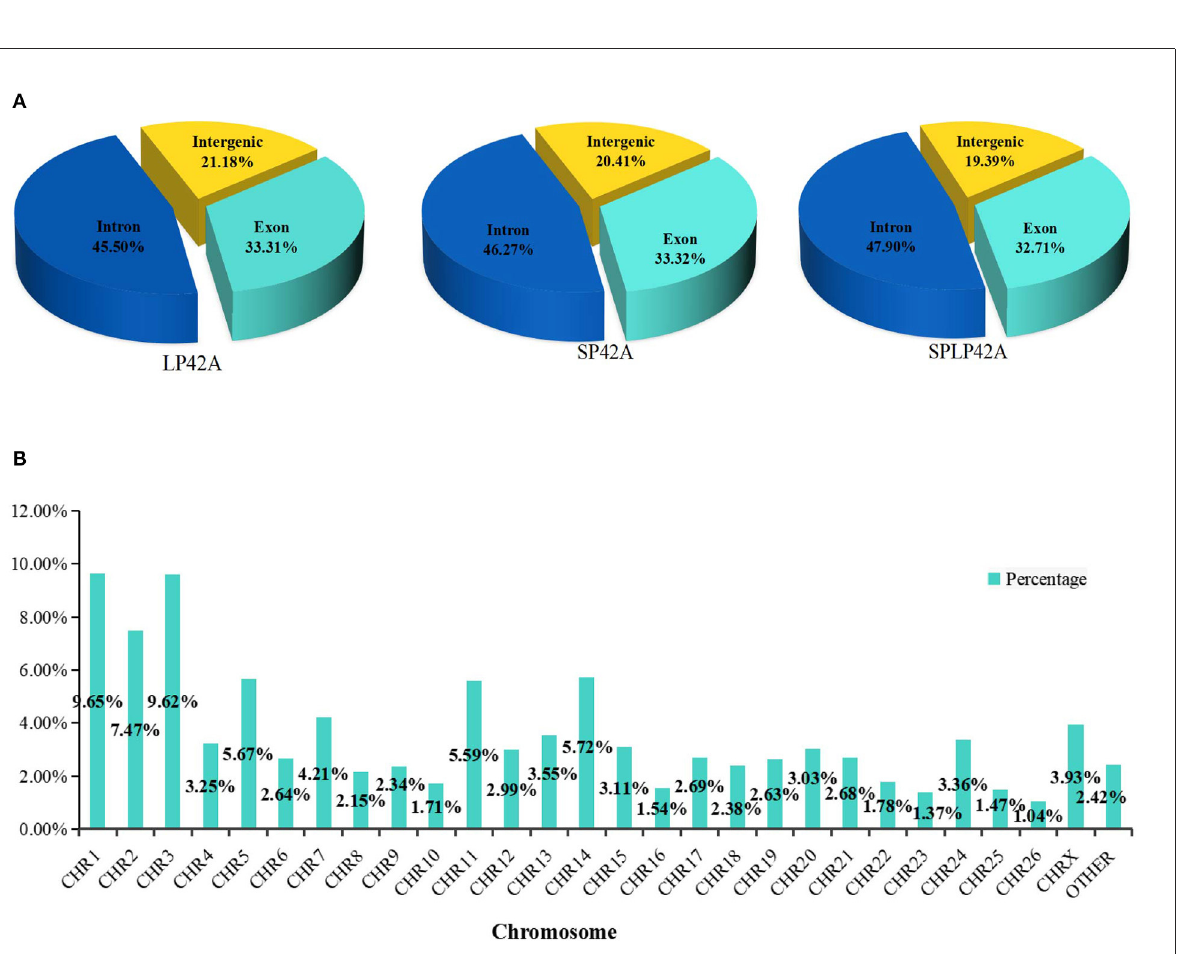
FIGURE1 Summary information of mRNA identification. (A) According to the sequence alignment information, the number of sequences aligned to exons, introns and intergenic regions was calculated, and the pie chart was made according to the proportion. (B) Chromosome distribution of identified genes from the adrenal